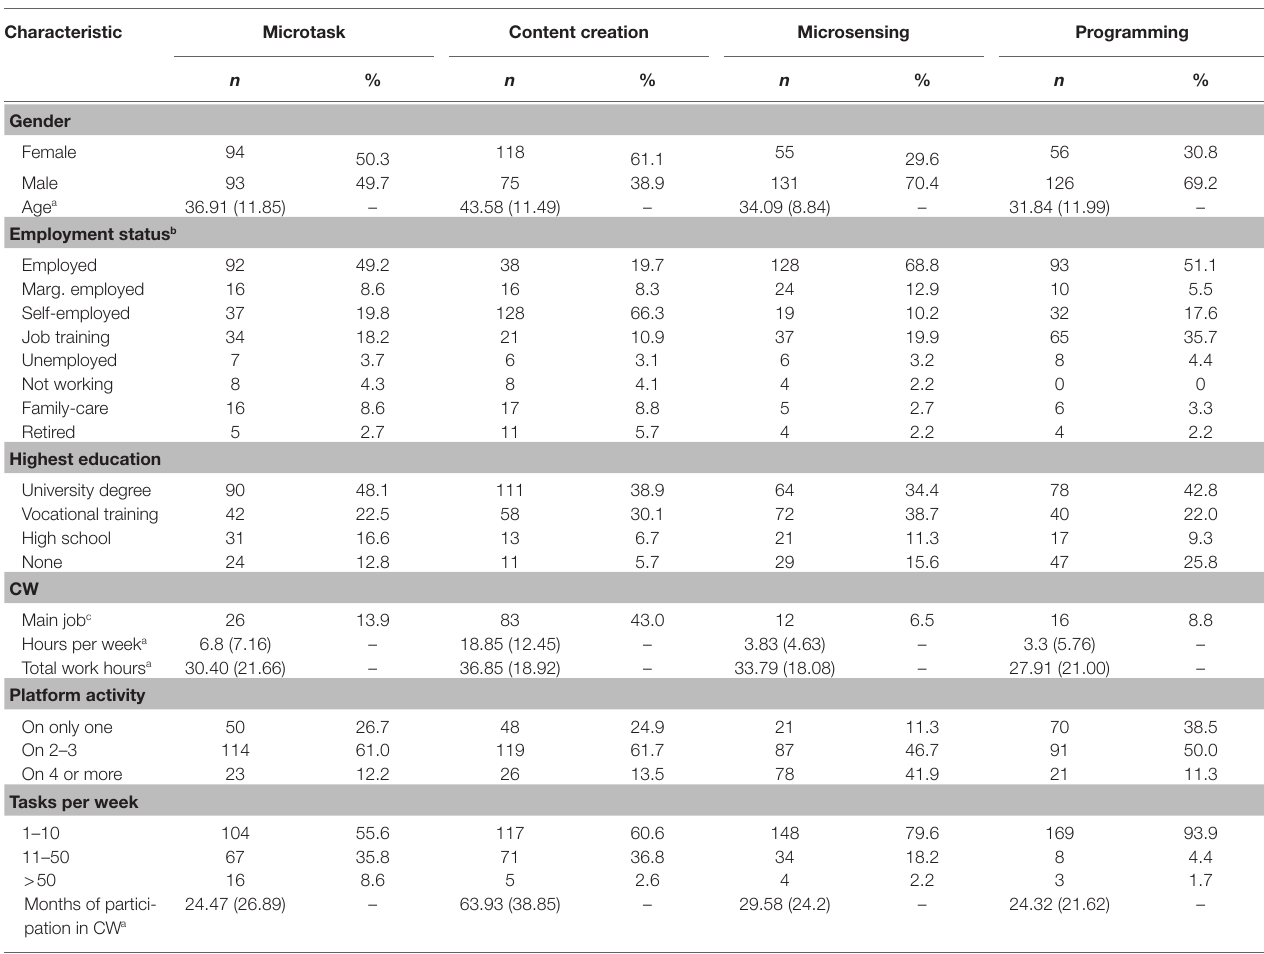
TABLE 1 | Sociodemographic characteristics of